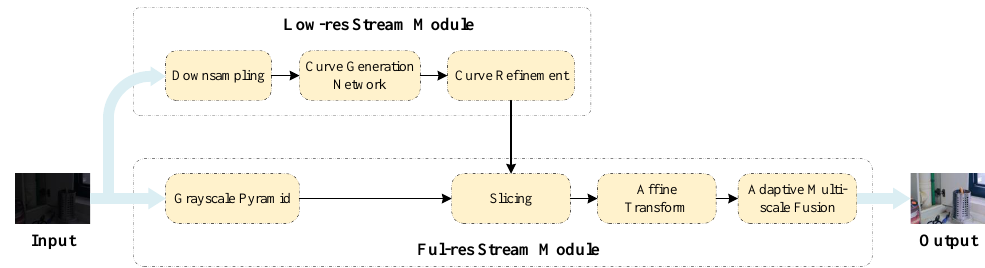
Figure 1. Flow chart of the proposed